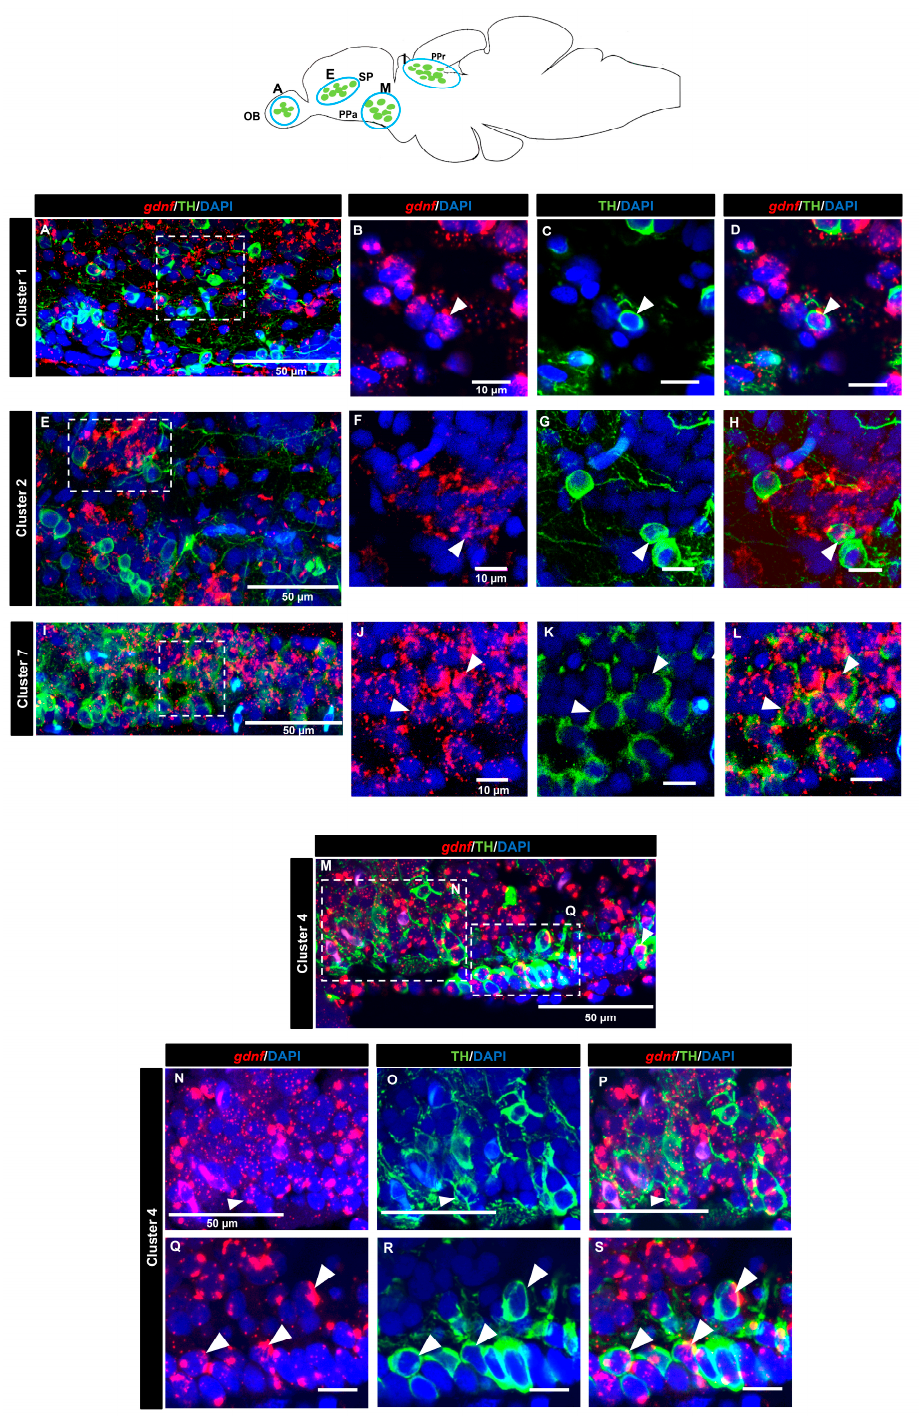
Figure 7. gdnf is expressed in catecholaminergic subpopulations in the telencephalon and pretectum region. Sagittal section of adult zebrafish brain showing some co-expression of gdnf in TH-positive neurons of ( A – D ) cluster 1 in olfactory bulbs (OB), and ( E – H ) cluster 2 in subpallium (SP). Clear co-expression is observed in ( I – L ) cluster 7 in periventricular pretectal nucleus (PPr) and ( M – S ) cluster 4 in parvocellular preoptic nucleus, anterior part (PPa). The white arrowheads represent the co-expression of gdnf and TH. Blue outlines in the graphical illustration represent the regions of the respective TH subpopulation neurons. White dashes outline the respective magnified regions that were constructed from selected